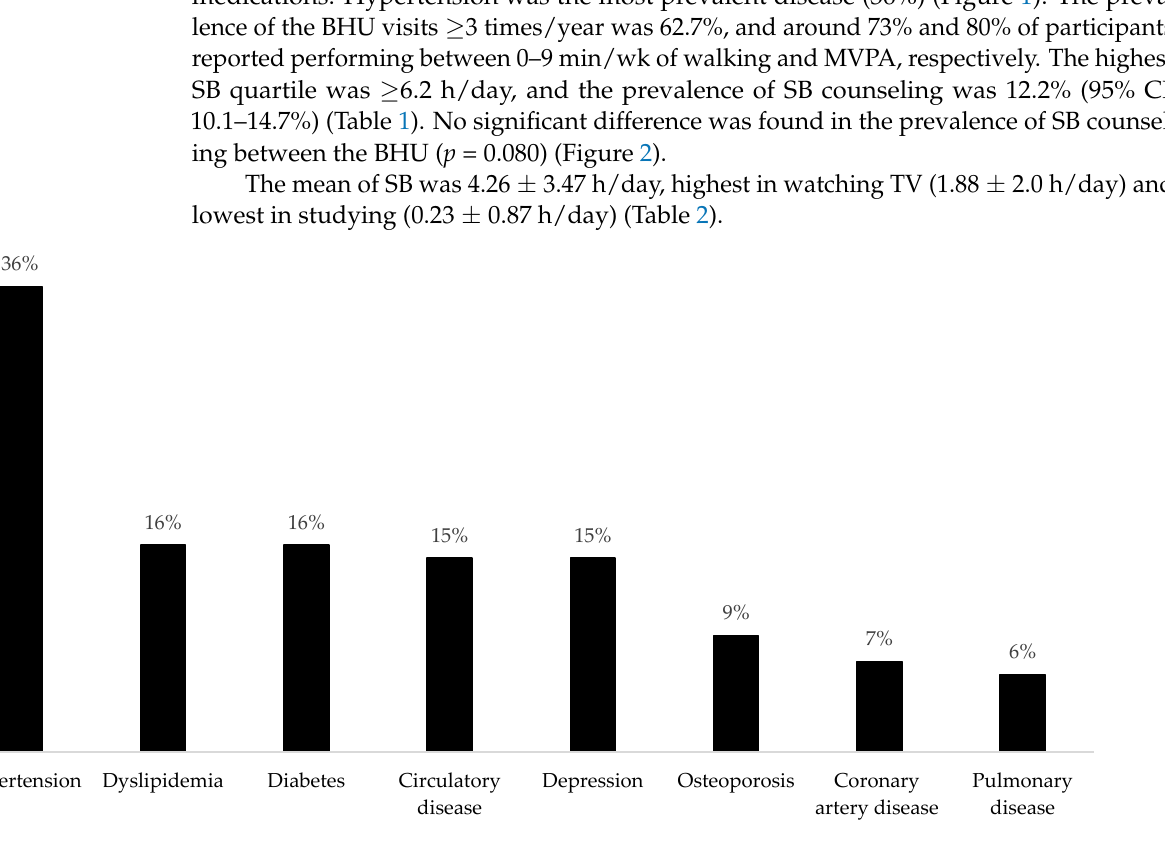
Figure 2. Prevalence of sedentary behavior counseling received from healthcare professionals by adults in each of the 15 basic health units evaluated. São José dos Pinhais, Paraná, Southern Brazil, 2019 (n = 779). The mean of SB was 4.26 ± 3.47 h/day, highest in watching TV (1.88 ± 2.0 h/day) and lowest in studying (0.23 ± 0.87 h/day) (Table 2).